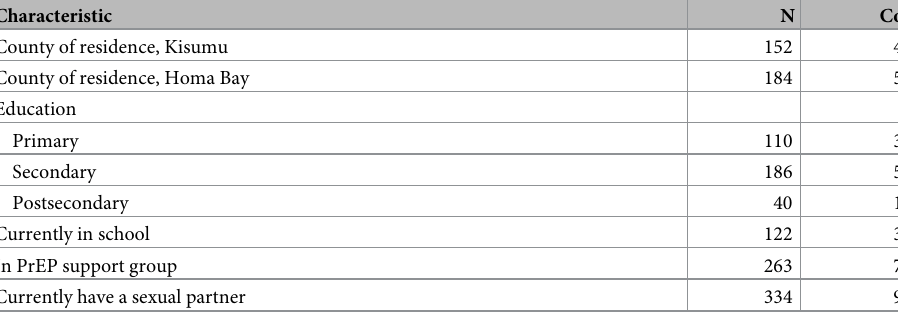
Table 1. Characteristics of 336 study participants at the first